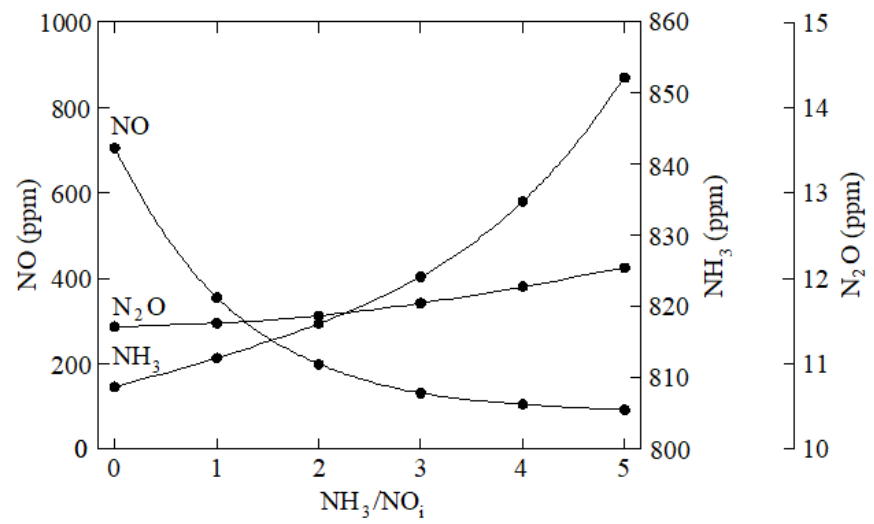
Figure 11. NO, N 2 O, and NH 3 emissions against the NH 3 /NO i ratio.